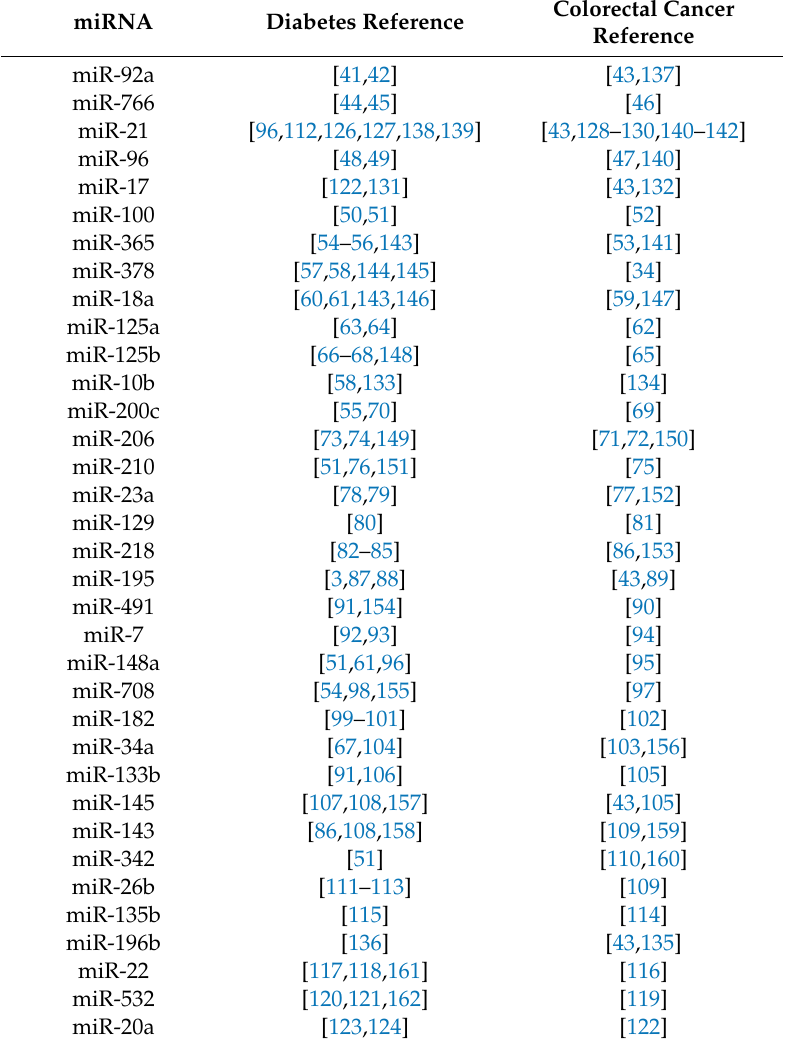
Table 1. miRNAs related to Diabetes and Colorectal